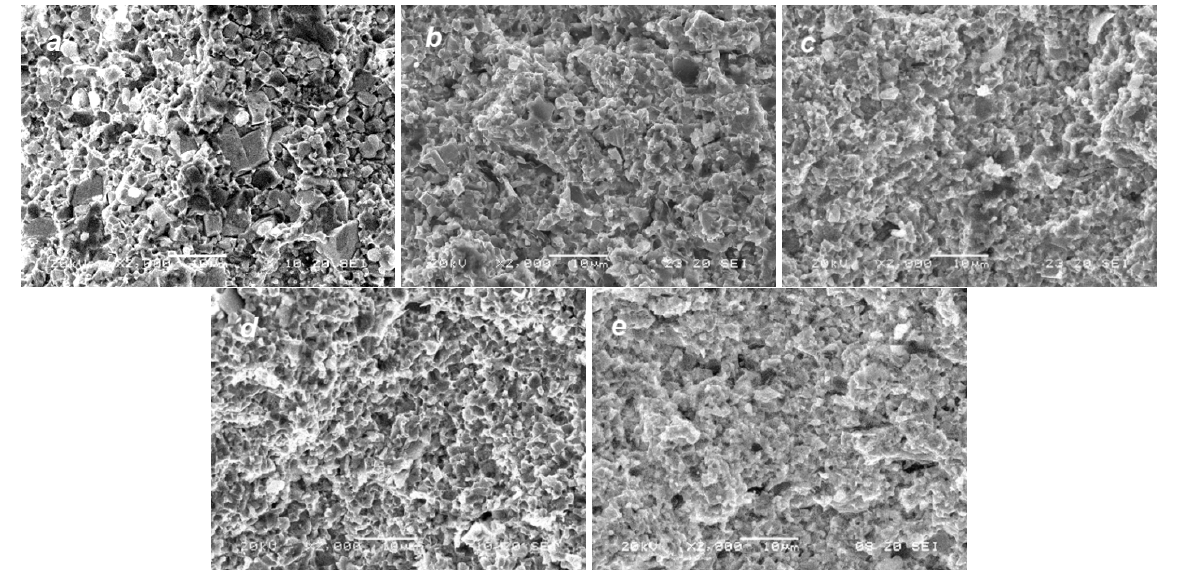
Figure 7: Fracture morphology of WC-TiC-Ni 3 Al based materials (a-homogeneous, b-n 1 = 0.5, c-n 1 = 1, d-n 1 = 2, e-n 1 = 4)